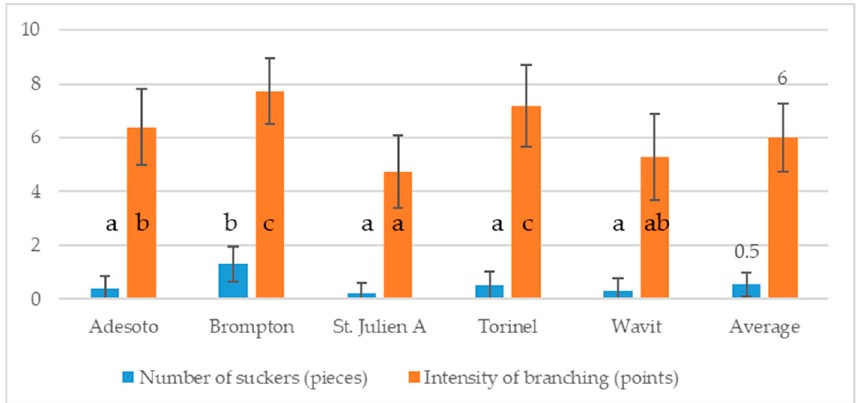
Figure 2. A comparison of the average values for root suckering and shoot formation on the stem of the saplings, by rootstock. Scale bars refer ± standard deviations. Letters refer to statistical grouping according to the Tukey HSD test. Small letters indicate statistically different homogeneous subgroups.